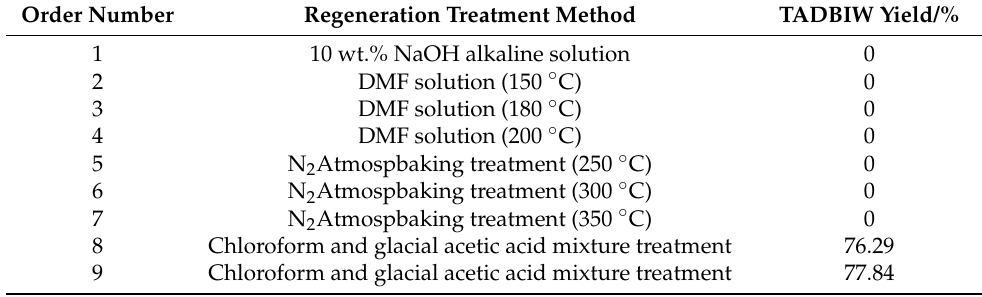
Table 1. Application of reacted 5 wt.%Pd/C catalyst obtained by different regeneration.